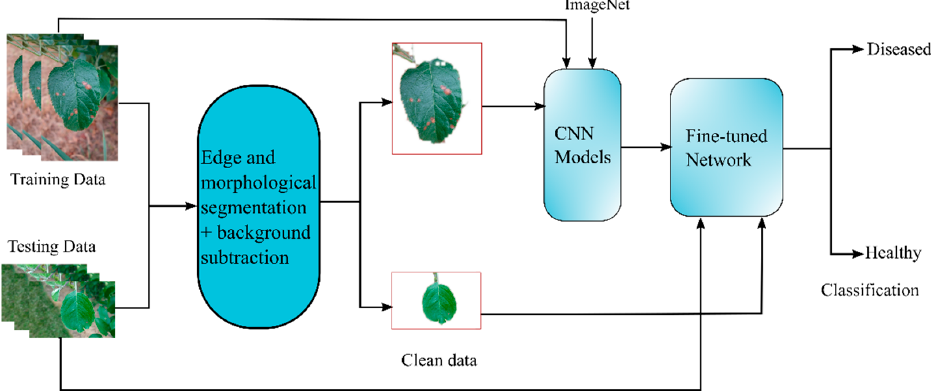
Figure 3. A framework of the proposed method.